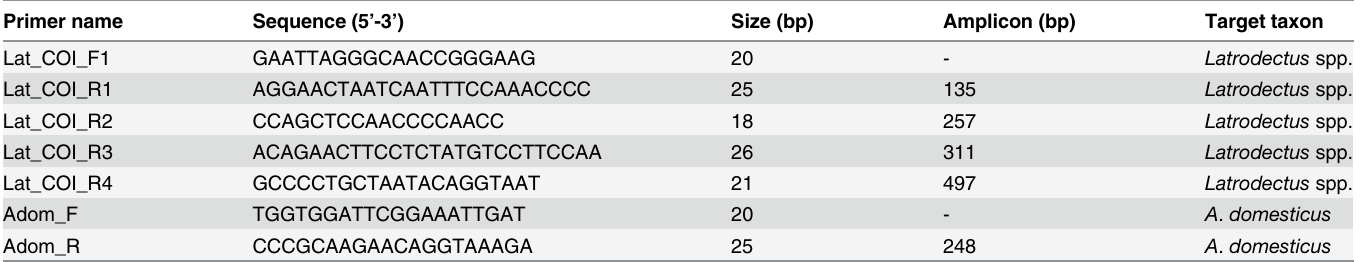
Table 1. PCR primers designed to amplify the cytochrome c oxidase subunit I (COI) gene of target